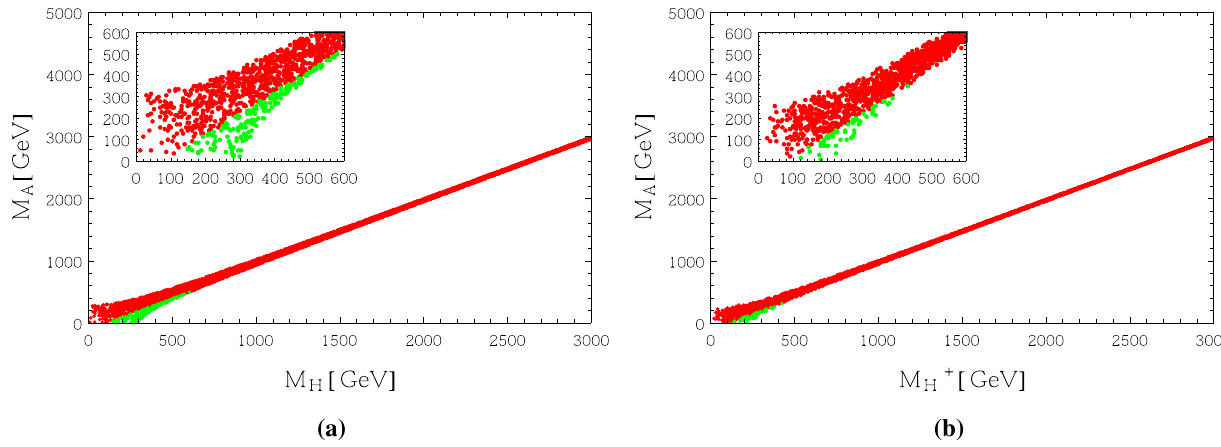
Fig. 1 a Mass correlation between M H and M A in GeV; b mass cor- 0 relation between M + and M A in GeV. Green color corresponds to mass H splitting greater than M W and red color corresponds to mass splitting